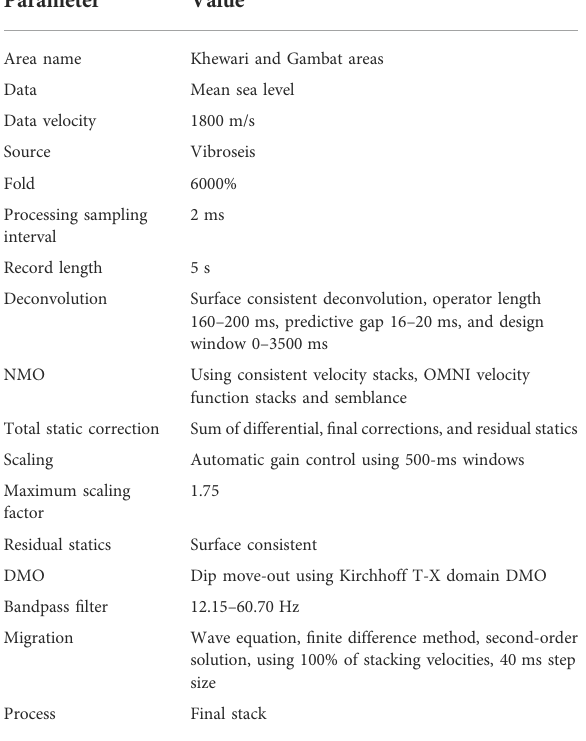
TABLE 1 Seismic data acquisition and processing parameters of the Khewari and Gambat areas used in this